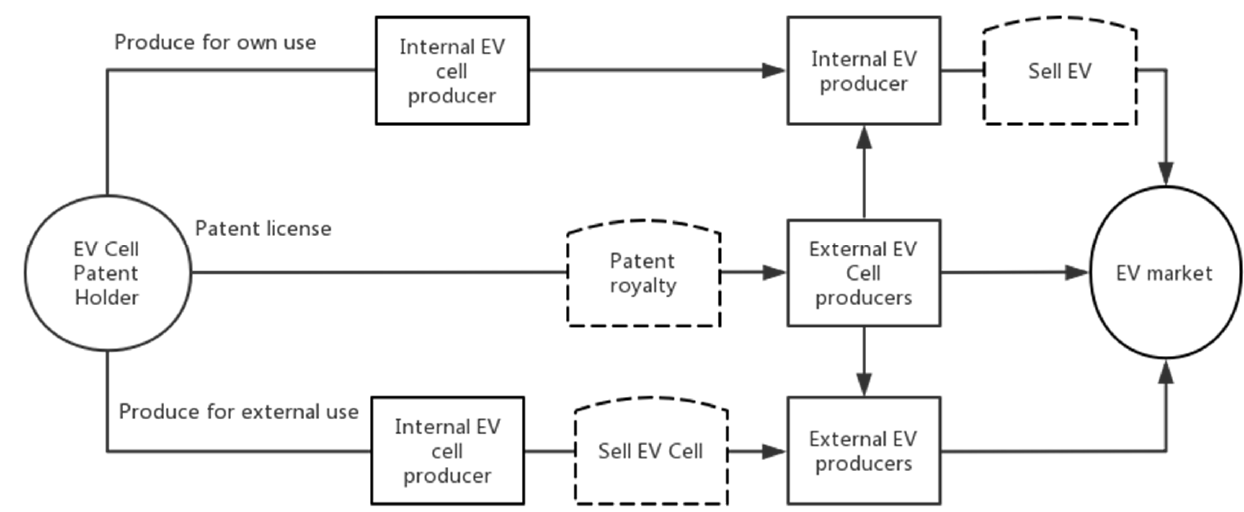
Figure 1. Innovation diffusion channel of EV cell.